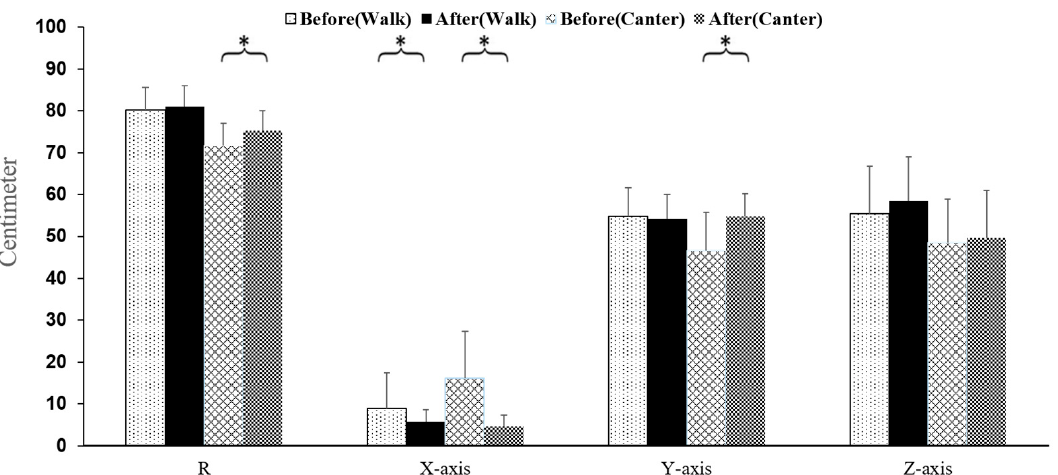
Figure 5. The displacement between the center of the head and the center of the neck. *: p < 0.05.